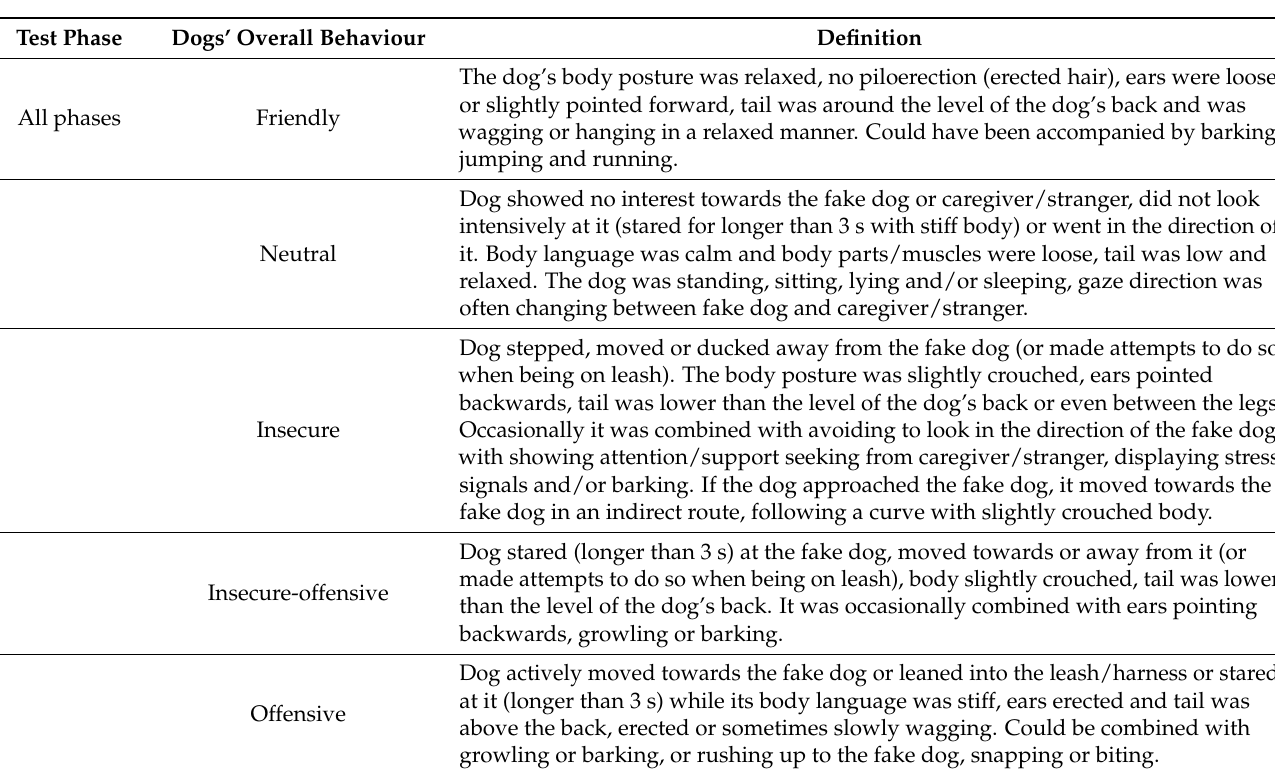
Table 3. Coded dogs’ overall behavioural reaction to fake dog in the respective test